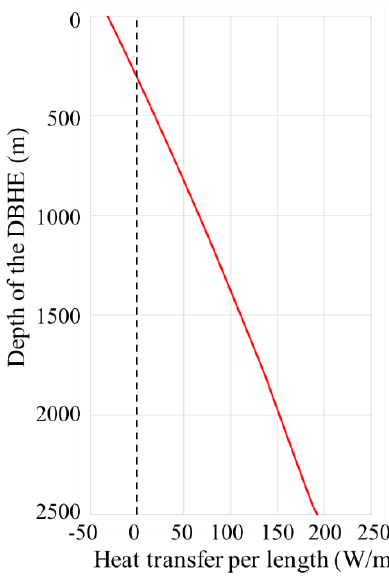
Figure 10. The calculated water temperature distribution in DBHE.